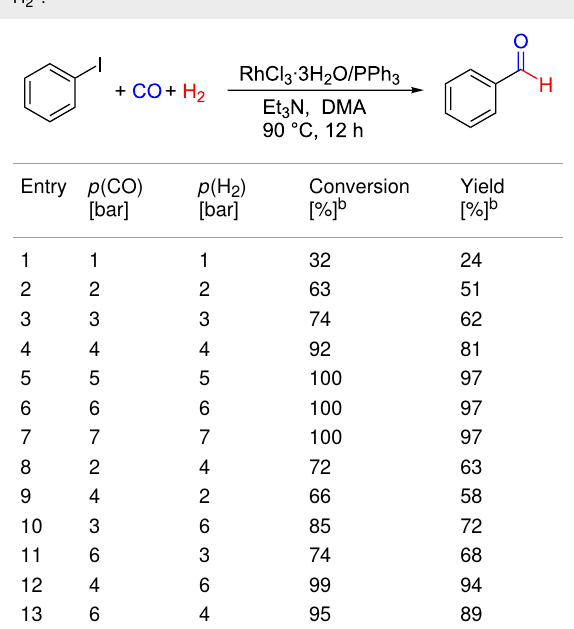
Table 3: Rhodium-catalyzed reductive carbonylation of iodobenzene with CO and H 2 to afford benzaldehyde: effect of pressures of CO and H 2a